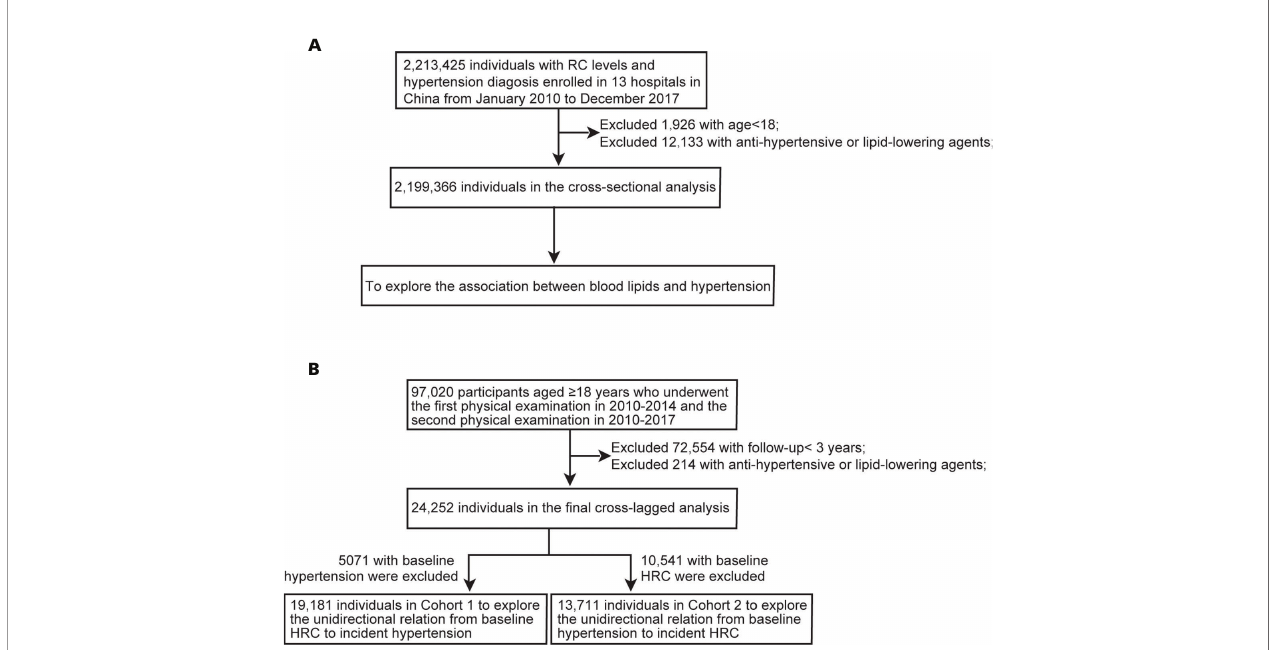
FIGURE 1 | Flow chart of participants. (A) Flow chart of participants in the cross-sectional analysis. (B) Flow chart of participants in the longitudinal analysis. RC, remnant cholesterol; HRC, high remnant